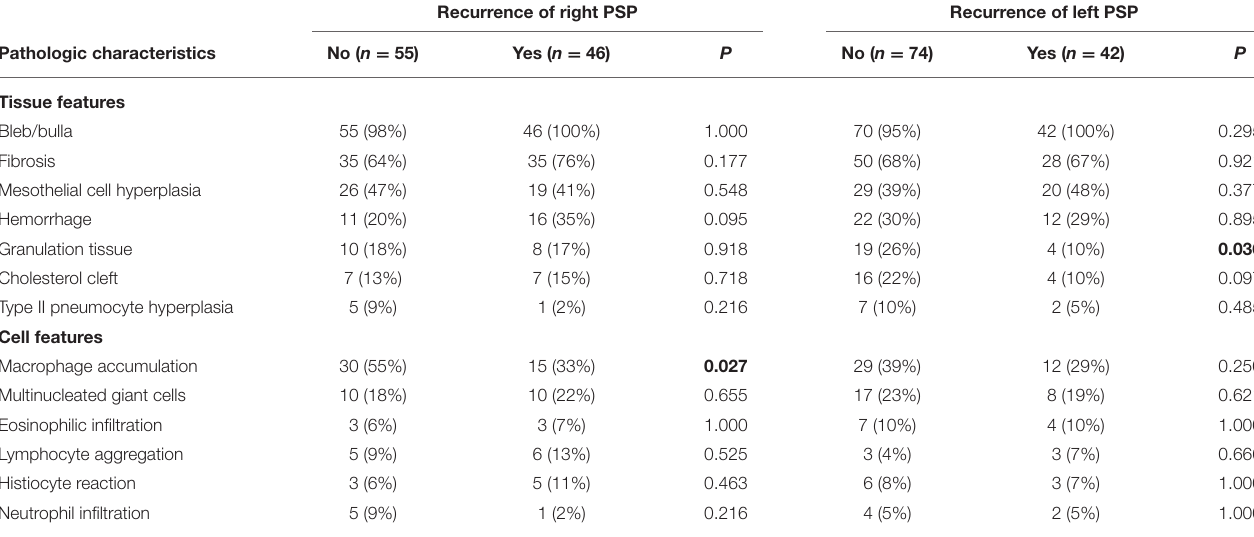
TABLE 1 | Comparison and difference of pathologic characteristics between adolescent PSP with and without recurrence when having VATS. Recurrence of right PSP Recurrence of left